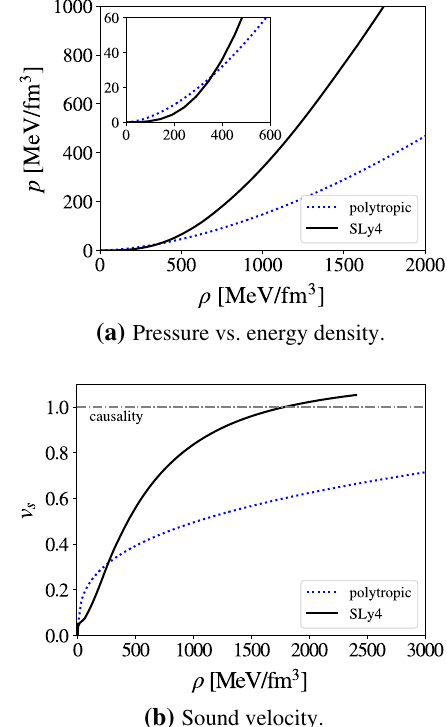
Fig. 1 Equationofstateproperties.Soundvelocity, v s ,mustrespectthe causal limit, which states v s < 1. Bottom panel shows that polytropic EoS does not violate causality, while SLy4 does violate for densities slightly above the star central density for the maximum mass star in GR (see Fig. 3b).